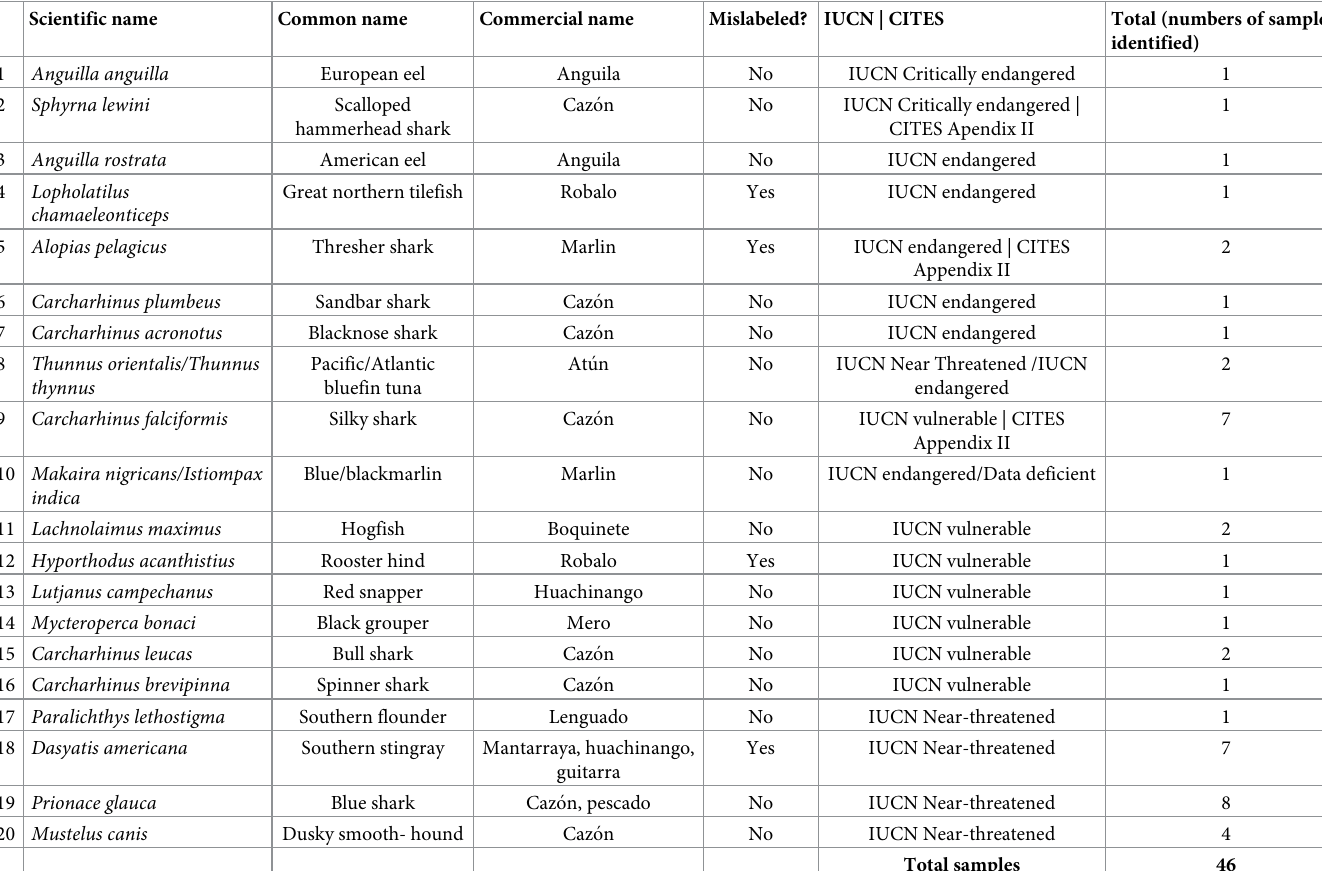
Table 4. List of 20 threatened and near threatened species identified in this study, including scientific name, common name, commercial name under which they were sold, if the sample was mislabeled or not, IUCN red list category, and if the species is included in any of CITES appendices, and total number of samples